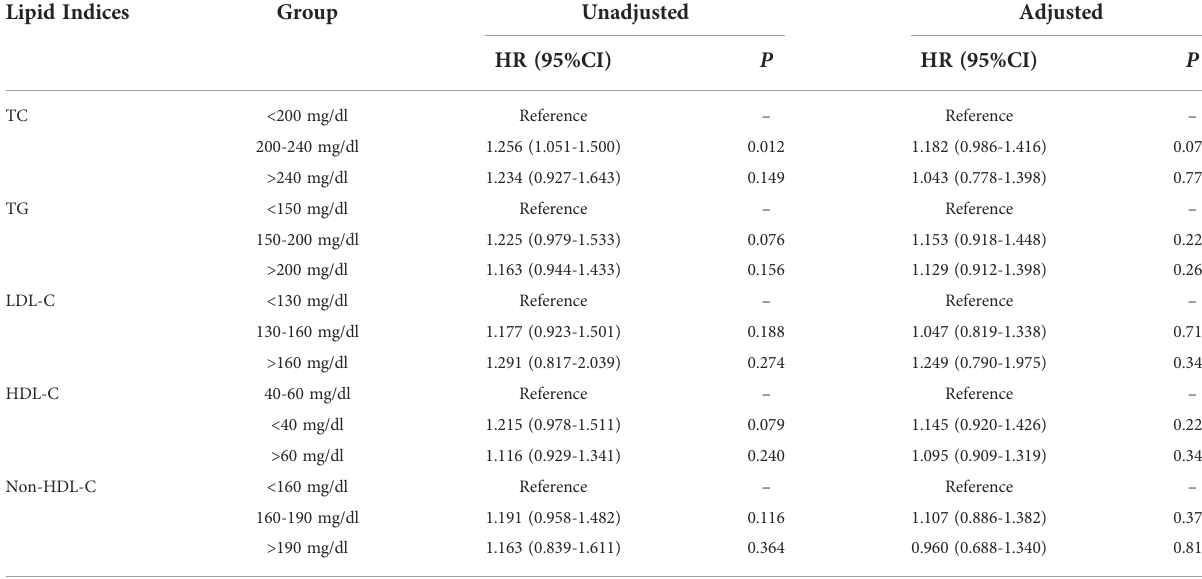
TABLE 2 Association between lipid indices and hypertension incidence during follow-up in the whole study population. Lipid Indices